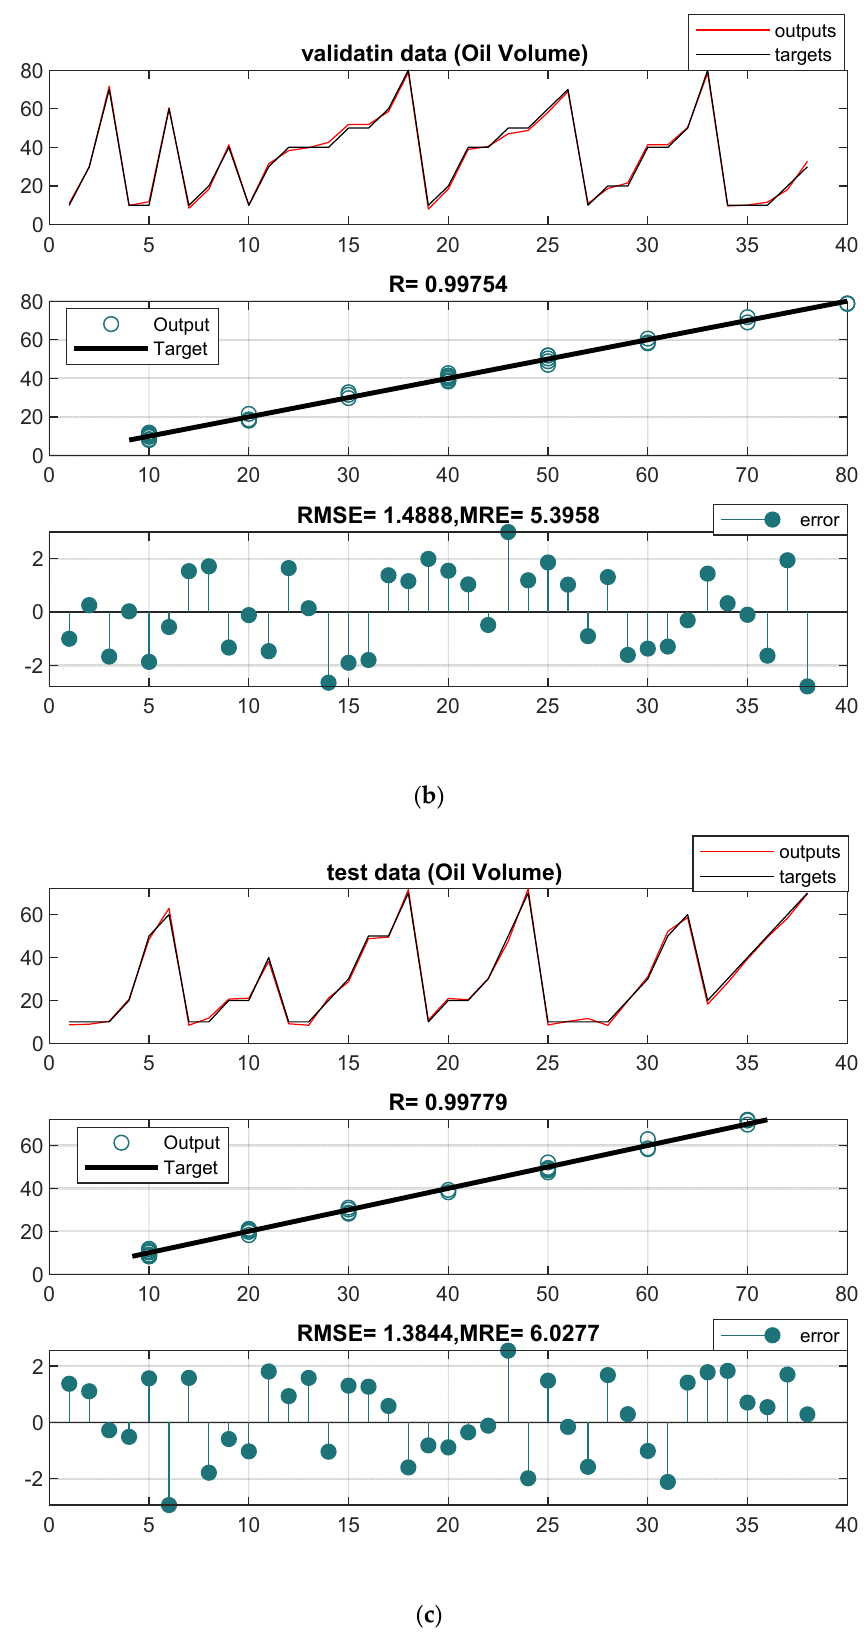
Figure 5. Fit and error graph for ( a ) training, ( b ) validation, and ( c ) testing data related to gas volume percentage predictor neural